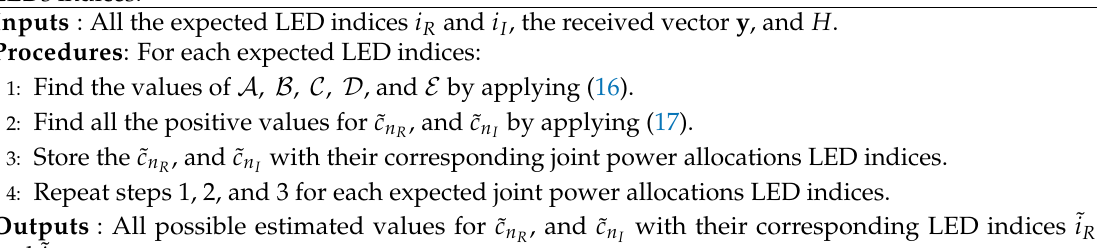
Algorithm 1 Estimating the values of ˜ c n LEDs